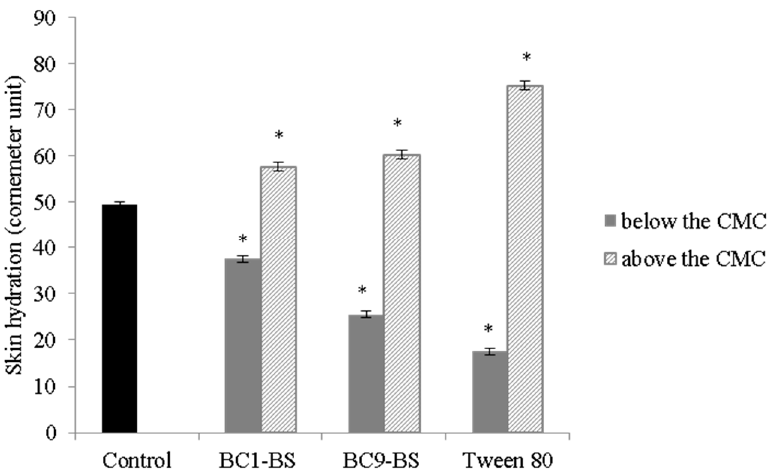
Figure 3. Skin hydration values (Corneometer unit) after treatment with surfactants at a concentration below and above the CMC. Data are expressed as means ± SD, n = 3. Significance indicated by * = p < 0.05 compared to the control.